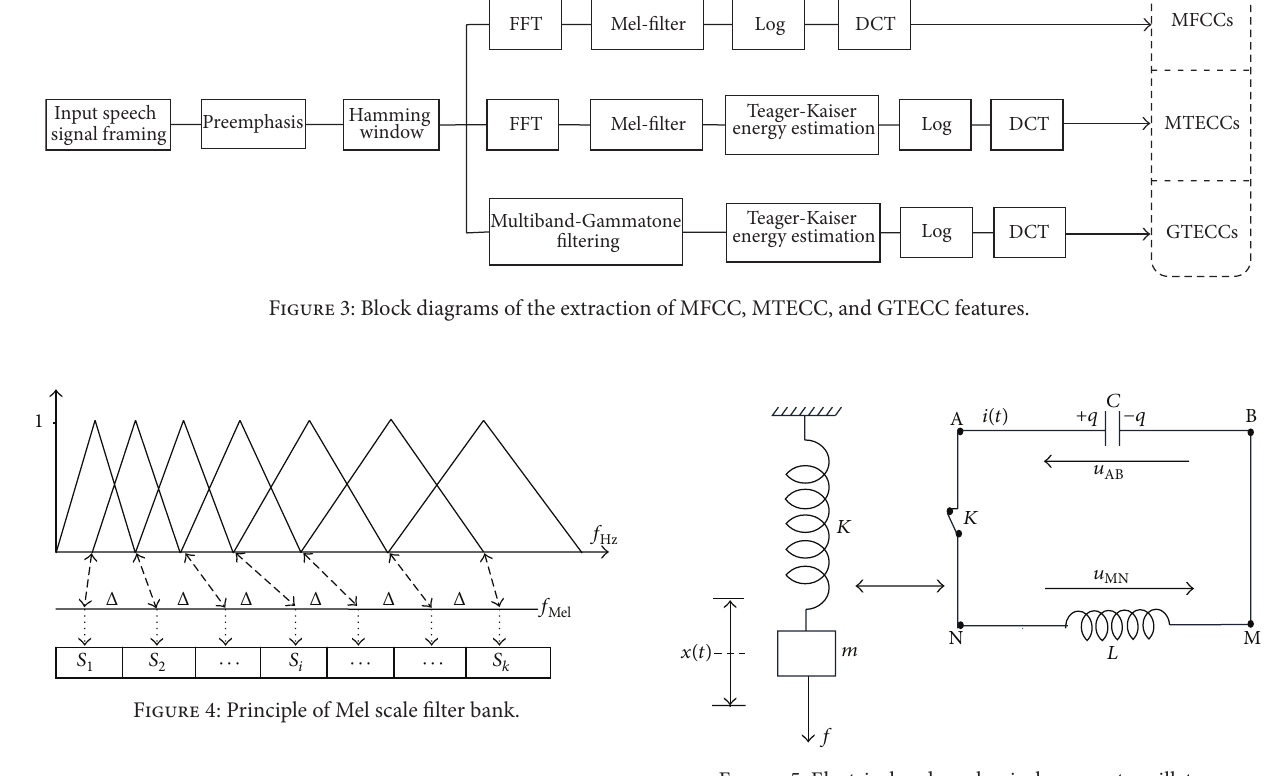
Figure 5: Electrical and mechanical resonant